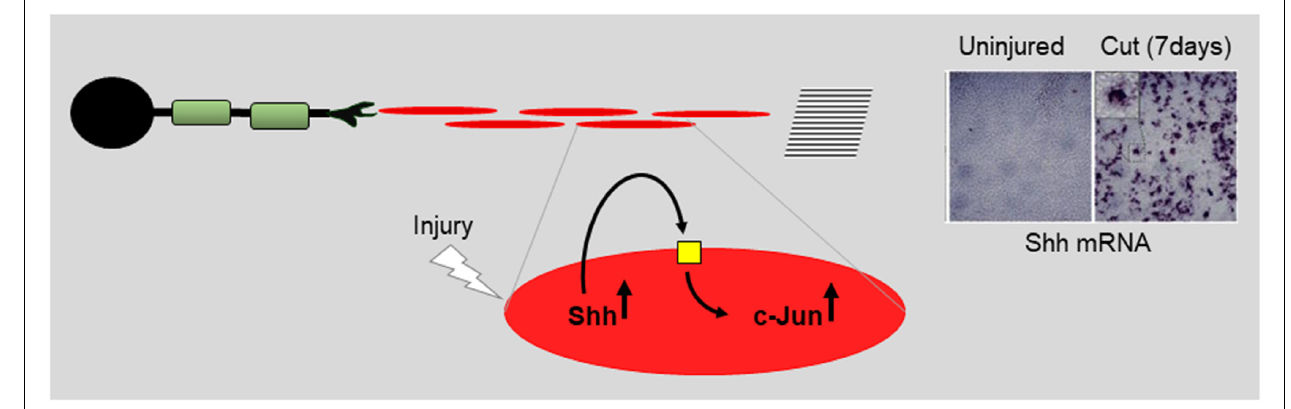
FIGURE 10 | Repair cells are supported by autocrine signaling loops. Using data on Shh (Wagstaff et al., 2021) the cartoon illustrates the notion that injury activates autocrine loops that support repair cells. Application or enhanced expression of autocrine signals constitute interesting candidates for future therapeutic